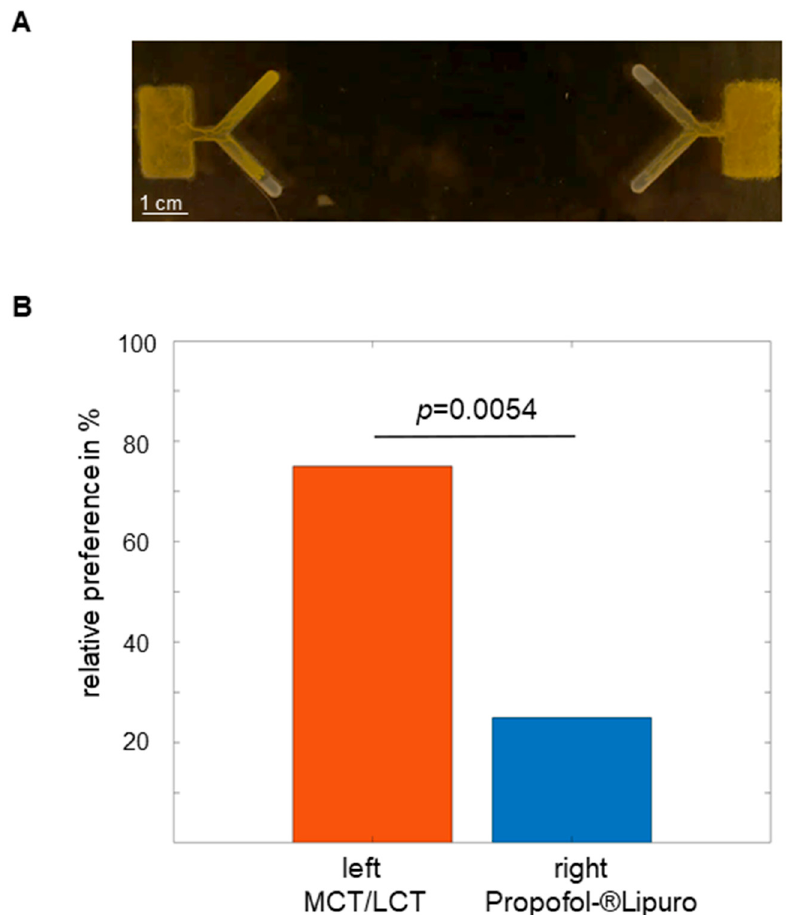
Figure 2. The 1-level Y-maze: ( A ) Exemplary experiment with Physarum in a dual 1-level Y-maze. Starting with a rectangular chamber, Physarum spreads out into the arms of the Y. A depot consisting of 3 µ L of MCT/LCT was placed at the tip of the left arm; correspondingly, a depot consisting of 3 µ L of Propofol- ® Lipuro was placed at the tip of the right arm. ( B ) Percentage representation of Physarum ´s directional decisions (total 30 experiments).